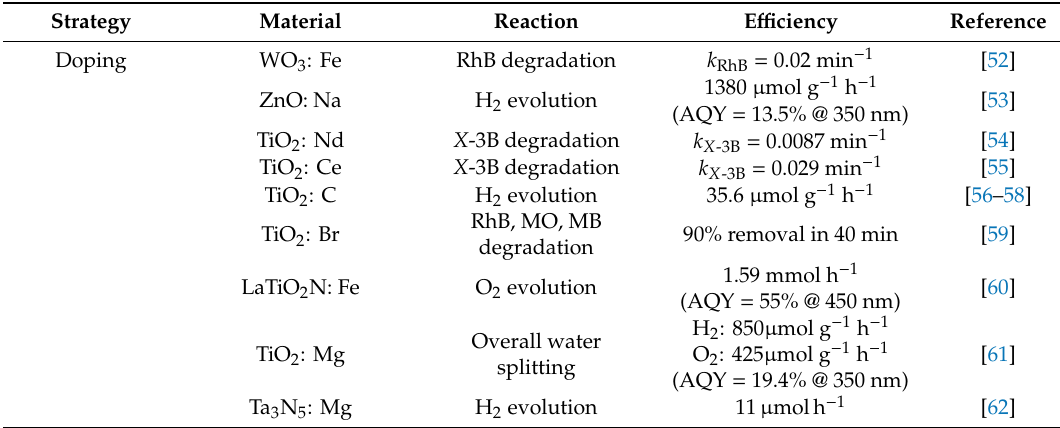
Table 1. Summary of carbon sphere template derived hollow nanostructure for photocatalysis. Strategy